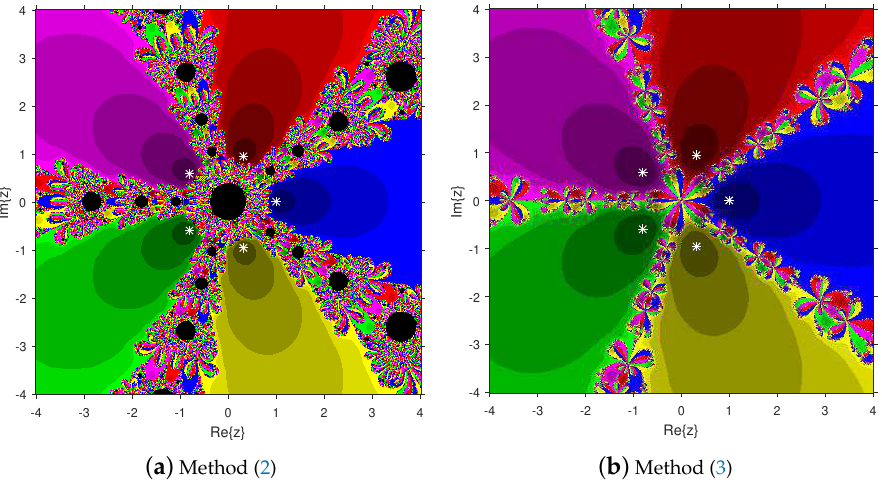
Figure 4. Comparison of attraction basins associated with fifth-degree polynomial O 4 ( z ) = z 5 −